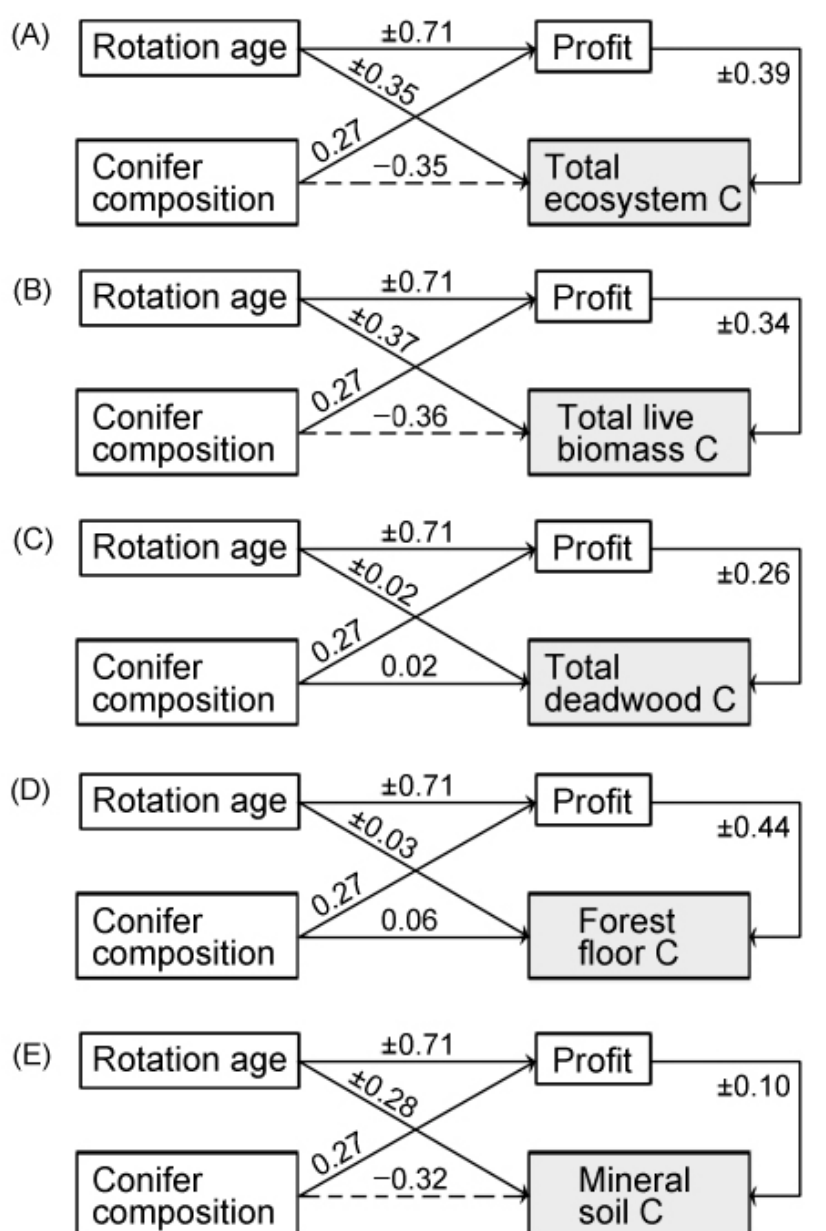
Figure 3. Path models showing multivariate relationships between forest management alternatives, profit and ( A ) total ecosystem carbon C, ( B ) total live biomass C, ( C ) total deadwood C, ( D ) forest floor C and ( E ) mineral soil C. Solid lines represent statistically significant positive paths, while dashed lines show the significant negative path. The coefficients are standardized for each casual path. The path coefficient marked with ‘±’ indicates a quadratic relationship.